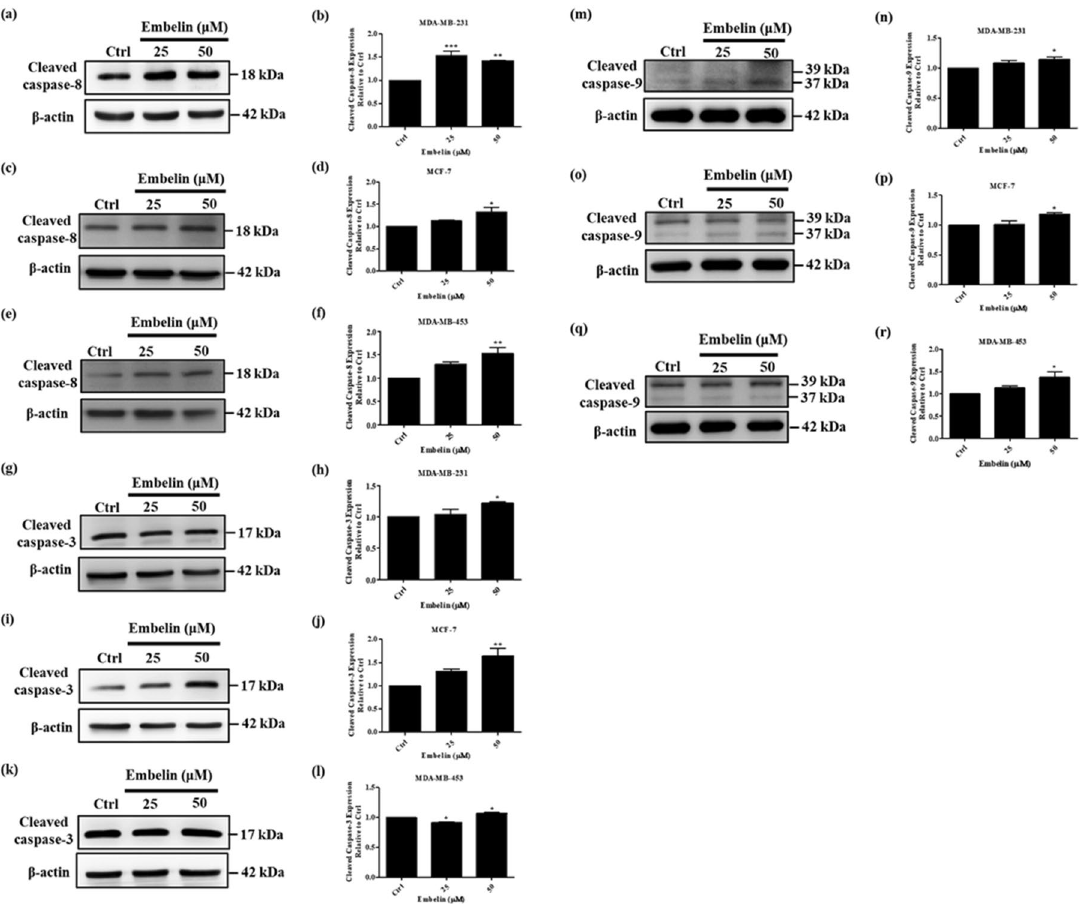
Figure 3. Embelin induced activation of caspase proteins in breast cancer cells. ( a , b ) MDA-MB-231 ( c , d ) MCF-7 and ( e , f ) MDA-MB-453 were treated with 25 and 50 μM embelin for 24 h. The cleaved caspase-8 expression and quantitative graphs of the Western blot results. ( g , h ) MDA-MB-231 ( i , j ) MCF-7 and ( k , l ) MDA-MB-453 were treated with 25 and 50 μM embelin for 24 h. The cleaved caspase-3 expression and quantitative graphs of the Western blot results. ( m , n ) MDA-MB-231 ( o , p ) MCF-7 and ( q , r ) MDA-MB-453 were treated with 25 and 50 μM embelin for 24 h. The cleaved caspase-9 expression and quantitative graphs of the Western blot results. The gray analysis of Western blots was normalized with β-actin. The full-length Western blots were shown in Supplementary Fig. S3. Data were shown as mean ± SEM and analyzed by one-way ANOVA with Dunnett’s test. (n = 3, * P < 0.05, ** P < 0.01, *** P <